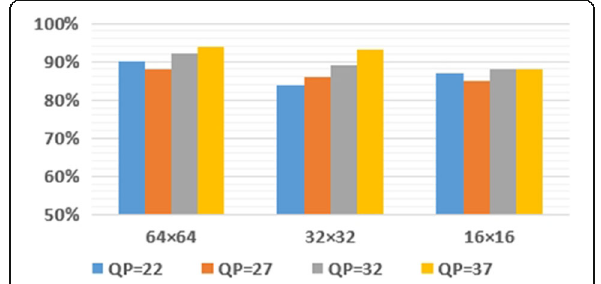
Fig. 9 Accuracy of early CU termination algorithm